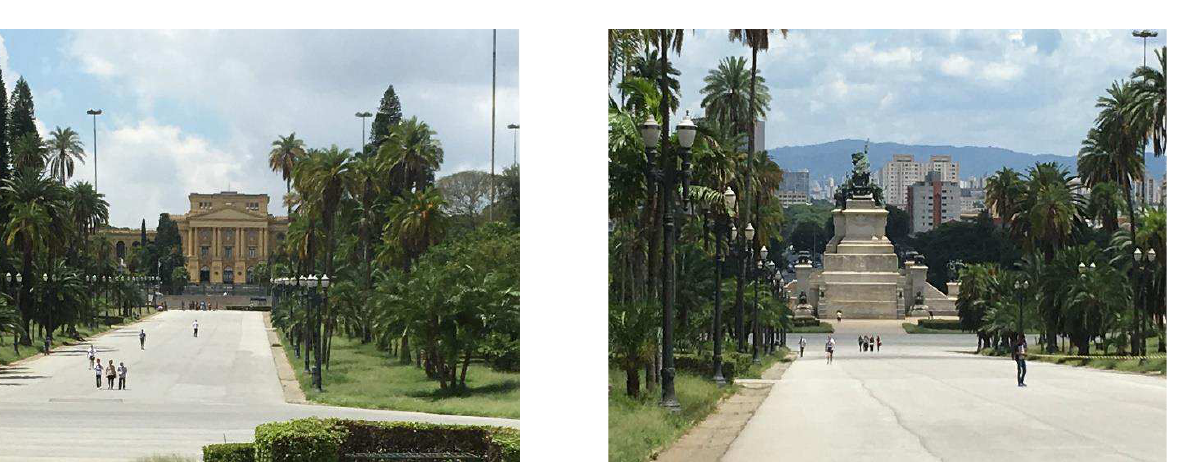
Figure 8. Museu do Ipiranga main façade: central perspective view from Monumento à Independência do Brasil and the relationship with the Parque da Independência.